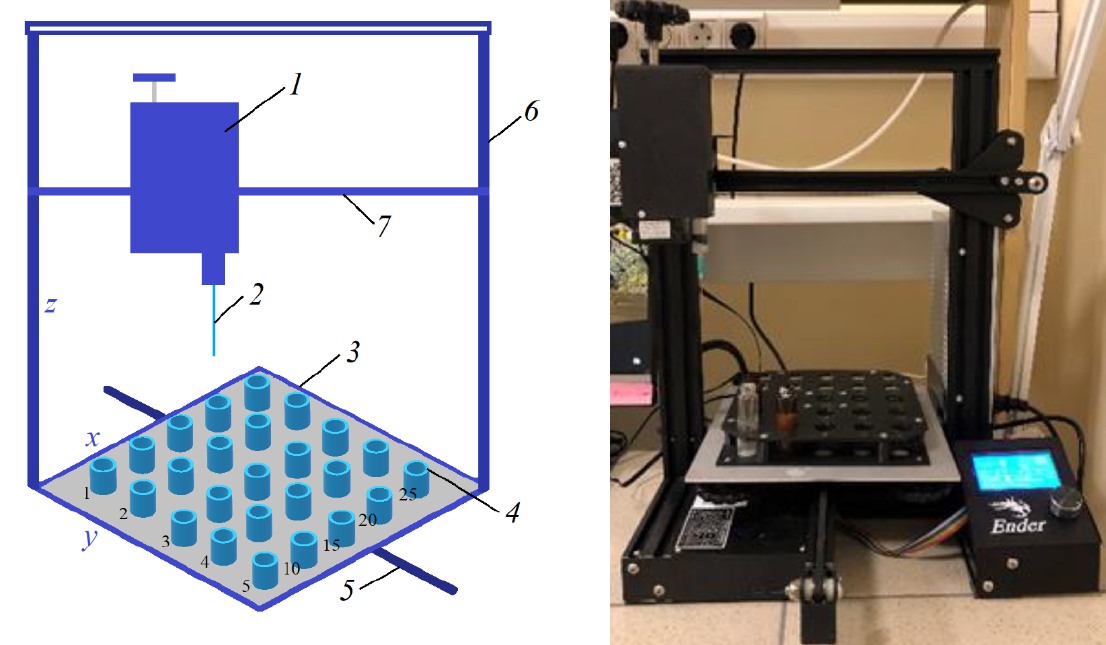
Figure 2. The original 3D printer used to cast PPSU hollow fiber membrane samples. The device includes a block (1) with a carrier needle (2) moving along vertical (6) and horizontal (7) bars in x, z coordinates. Samples of HF membranes were formed by succes- sively lowering the carrier needle into the bottles (4) with the spinning solution and then into the bottles (4) with the precipitant. The bottles with casting solutions and precipitants